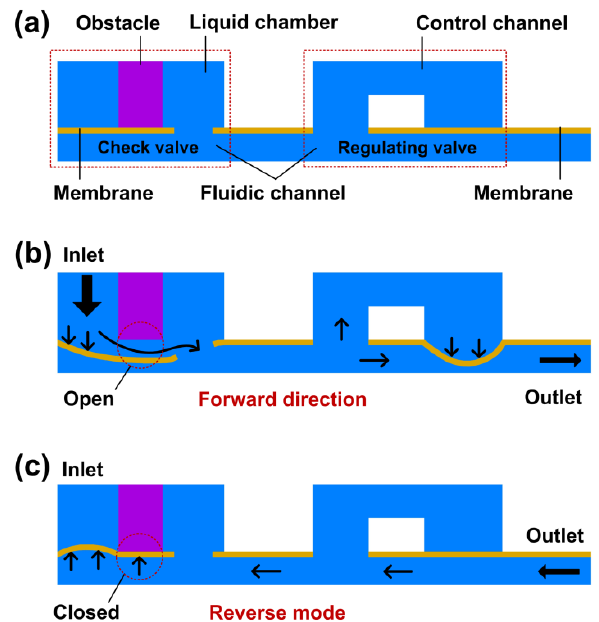
Figure 1. The working principle of the microfluidic flow regulatory device. ( a ) Concept microchannel structure of the device; ( b ) Flow check valve is opened to input the liquid in the forward mode, and a flow regulating valve controls the liquid flowing through the microchannel; ( c ) The flow check valve is closed to stop the liquid in the reverse